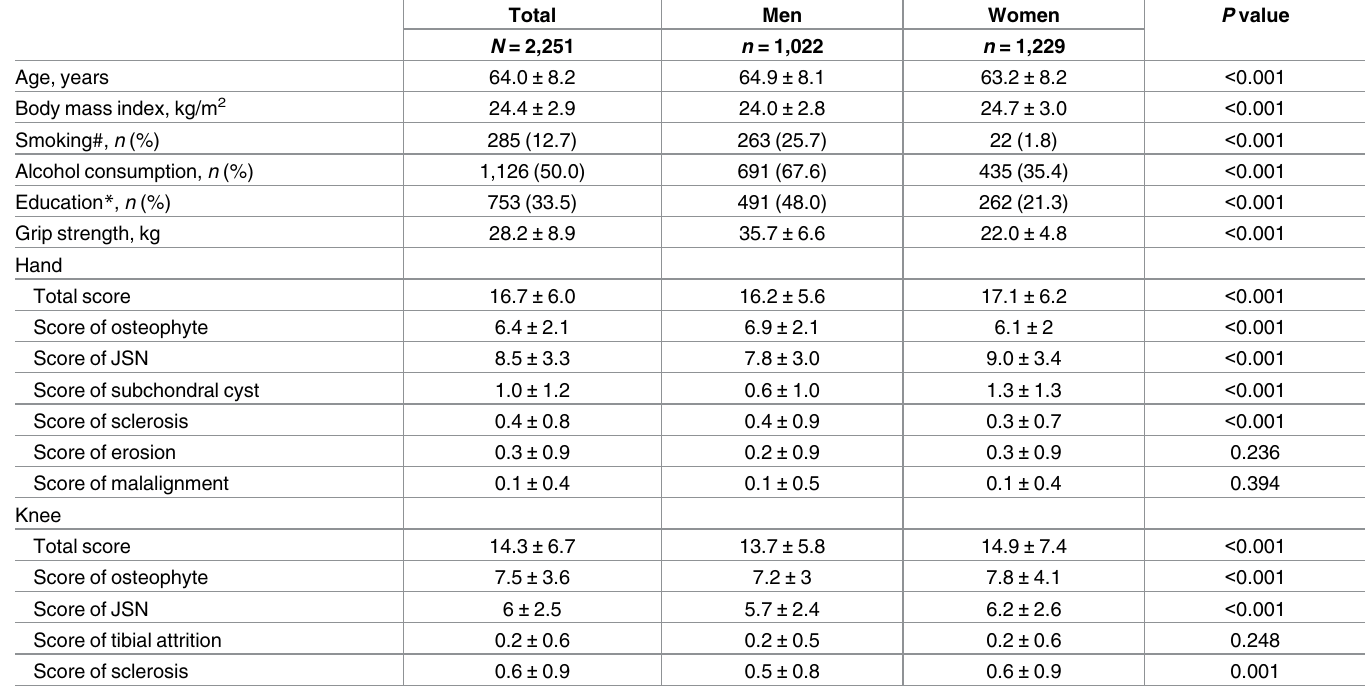
Table 1. Baseline characteristics of subjects without hand joint pain stratified by